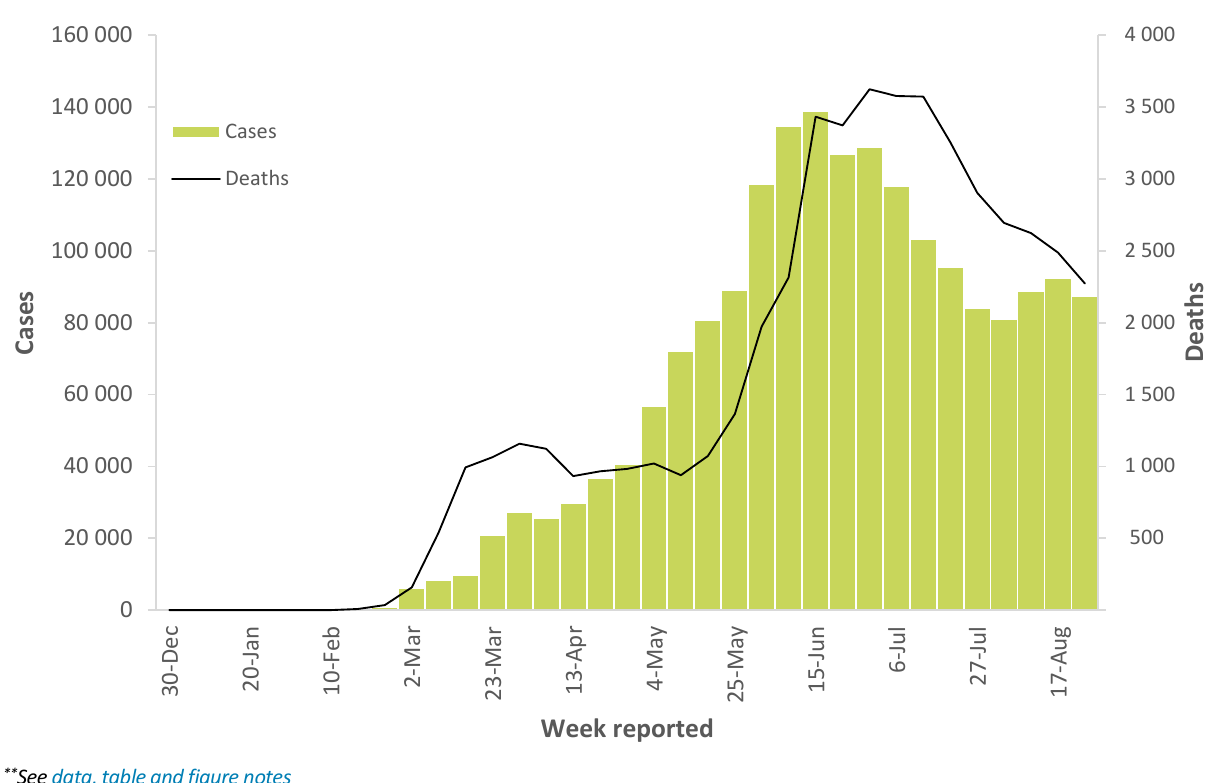
Figure 5: Number of COVID-19 cases and deaths reported weekly by Eastern Mediterranean Region, data as of 30 August 2020